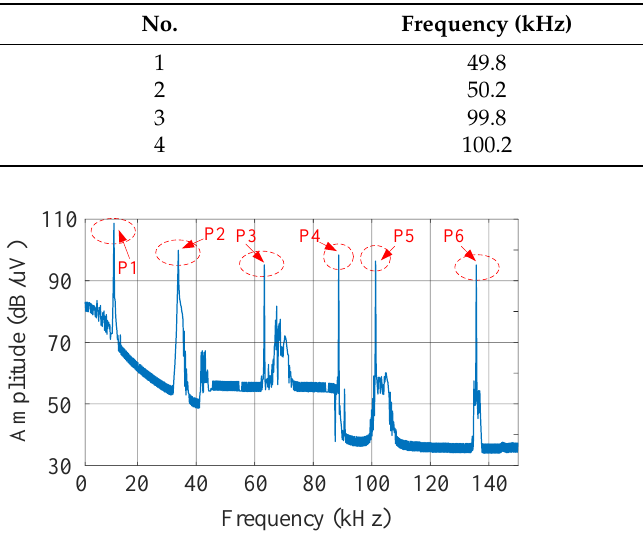
Table 1. Frequency and amplitude of single frequency test signals.